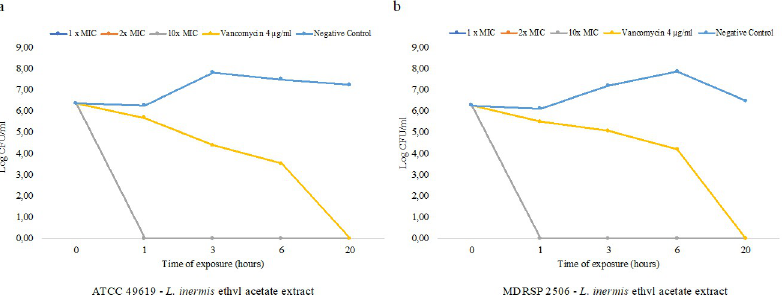
Fig 3. Time-killing curves over time of incubations of Lawsonia inermis ethyl acetate extract. a) S . pneumoniae ATCC 49619, b) MDRSP 2506. Time-killing assay was performed by direct platting with total plate count to measure viable cell during plant extract exposure at 0, 1 3, 6 and 20 hours of exposures. Lawsonia inermis final concentrations at 1 × MIC, 2 × MIC and 10 × MIC were used for incubation, vancomycin at final concentration 4 μ g/ml was used as growth control under antibiotic exposure while untreated cells were used as negative control. Curve 2 × MIC is overlapped with curve 10 × MIC showing similar effect of killing on S . pneumoniae .